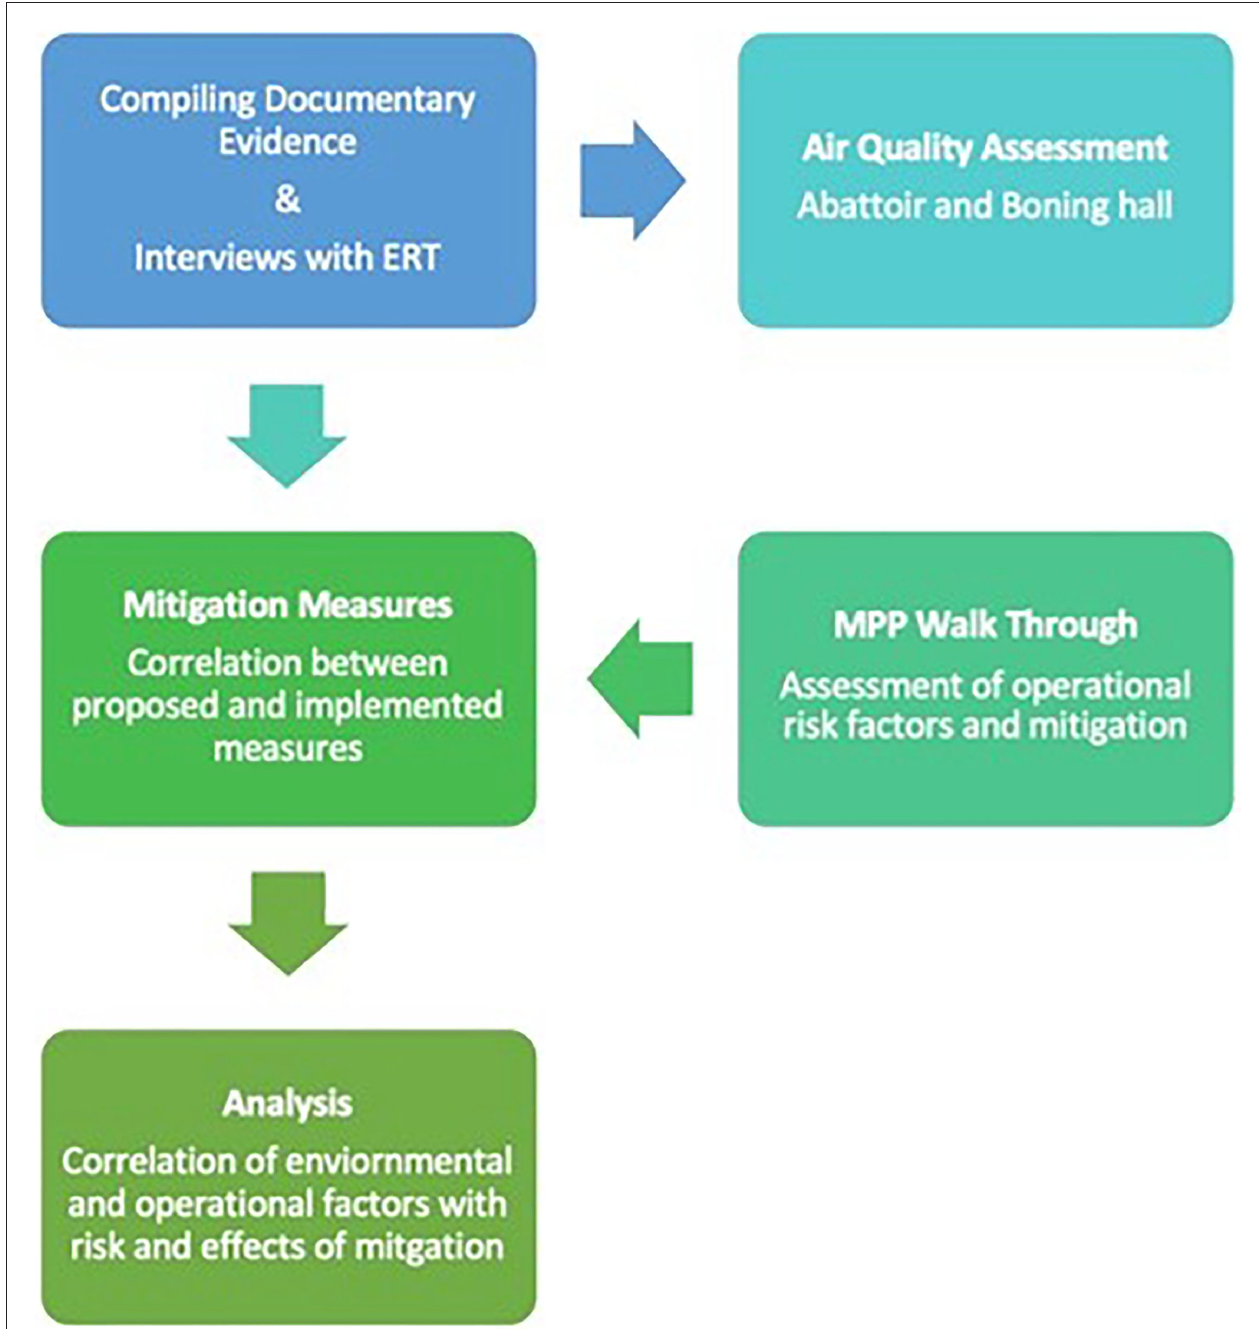
FIGURE 1 | Study design. An interdisciplinary study team was assembled which undertook to compile relevant data and information from plant management, carry out environmental assessments, and observe operational factors and implementation of risk-mitigation measures directly. MPP, Meat Processing Plant; ERT, Emergency Response